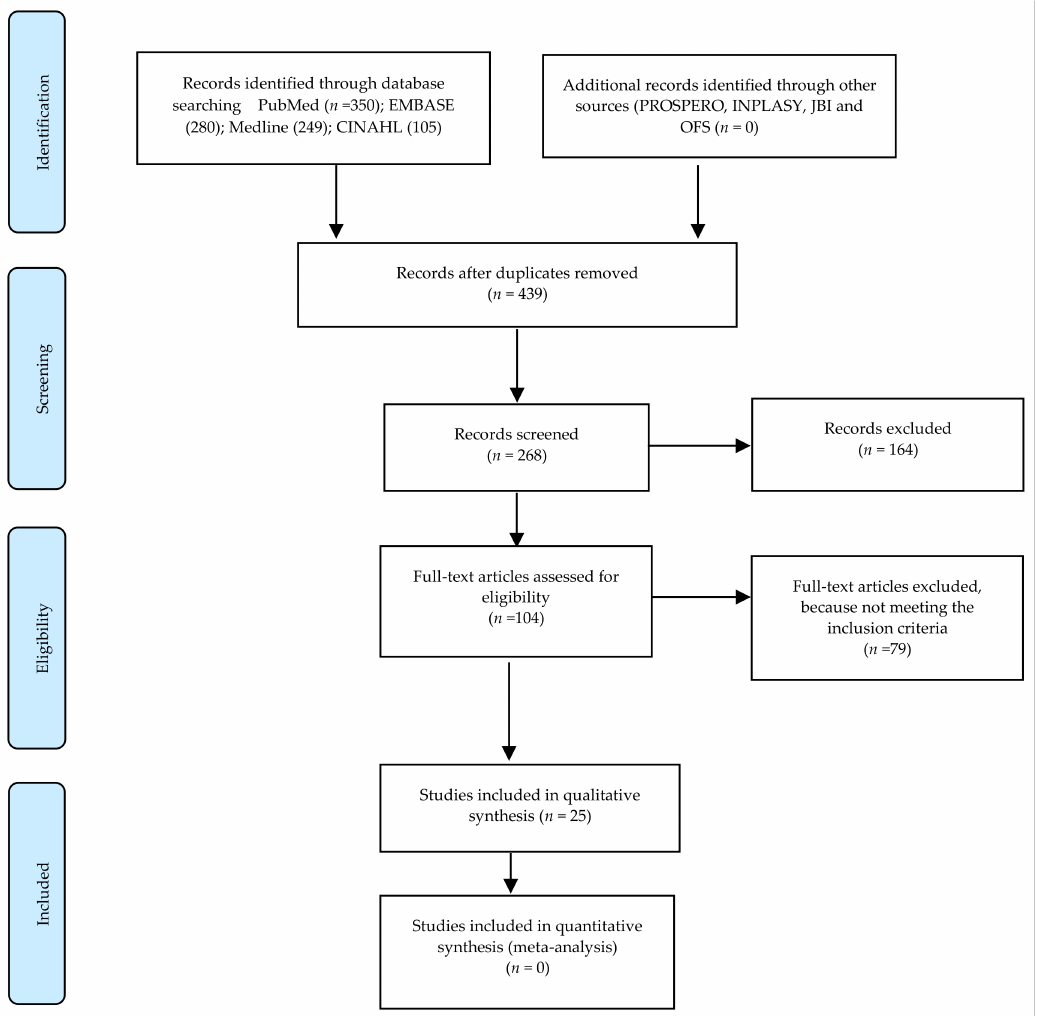
Figure 1. PRISMA study flow